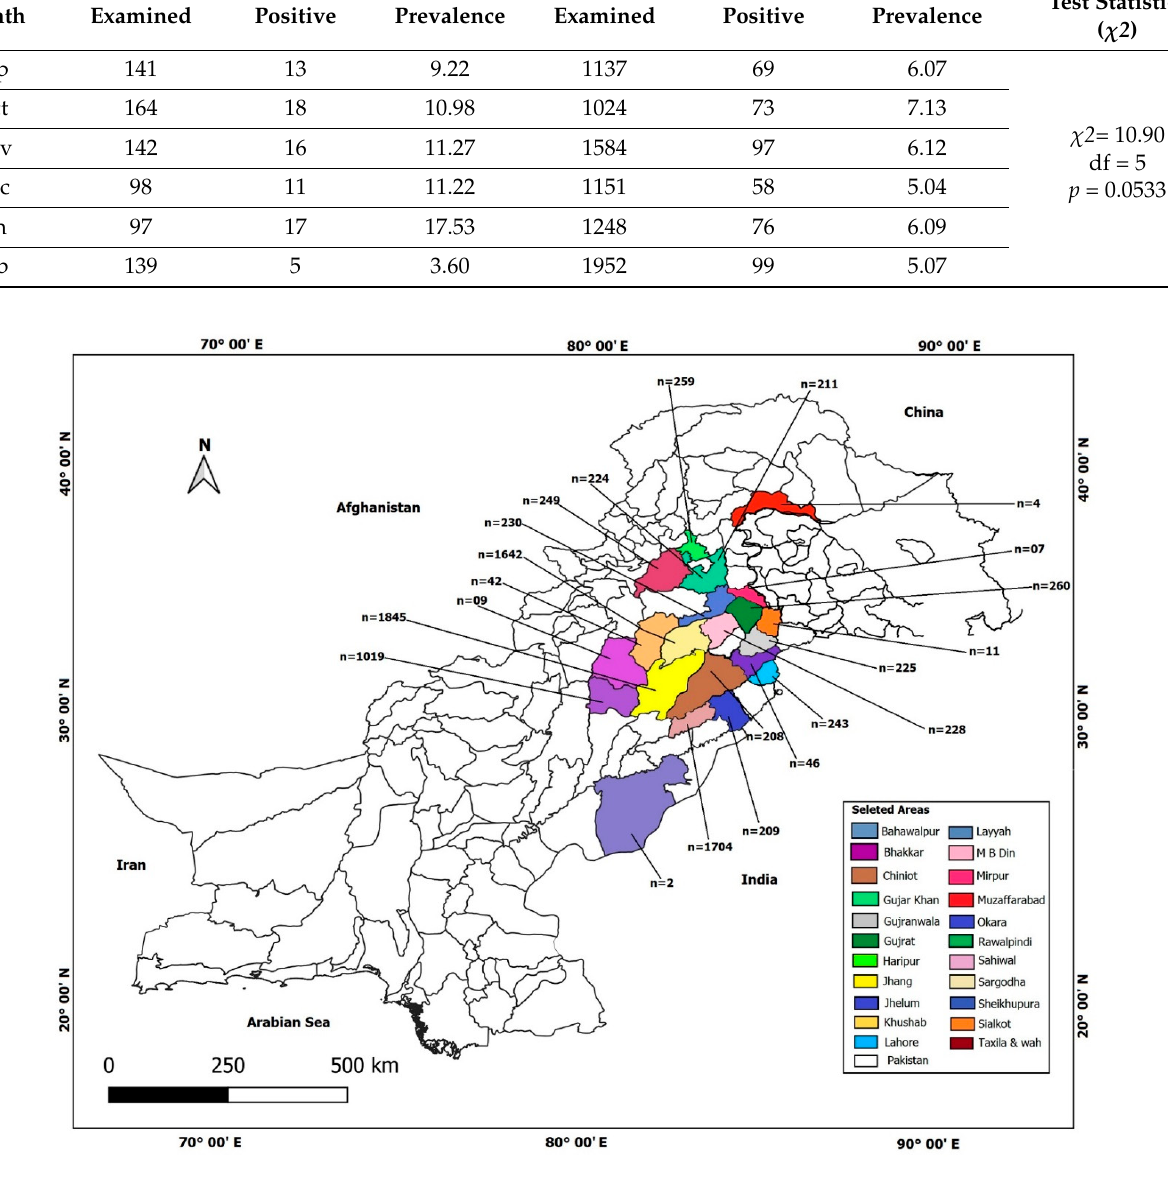
Figure 1. Map of Pakistan depicting distribution of animals examined (n is number of animals examined per district). Table 3. Characteristics of cysts isolated from infected